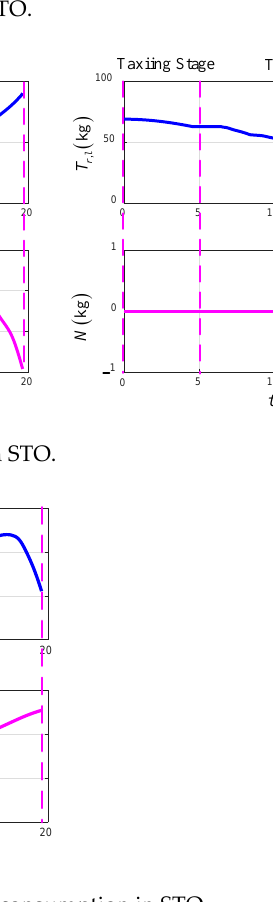
Figure 18. The power and energy consumption in STO.